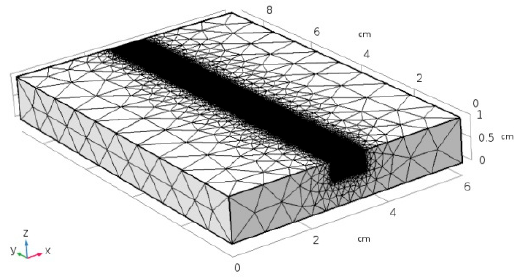
Figure 4. Triangle mesh of variable size on the virtual specimen.